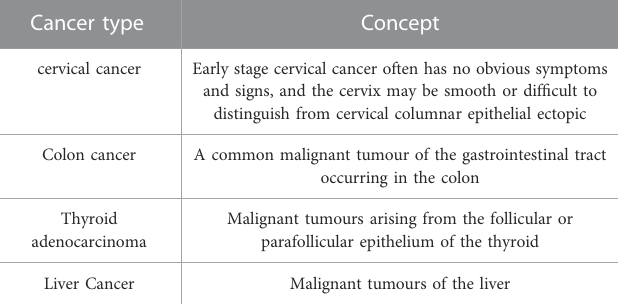
TABLE 1 Cancers investigated in the paper.